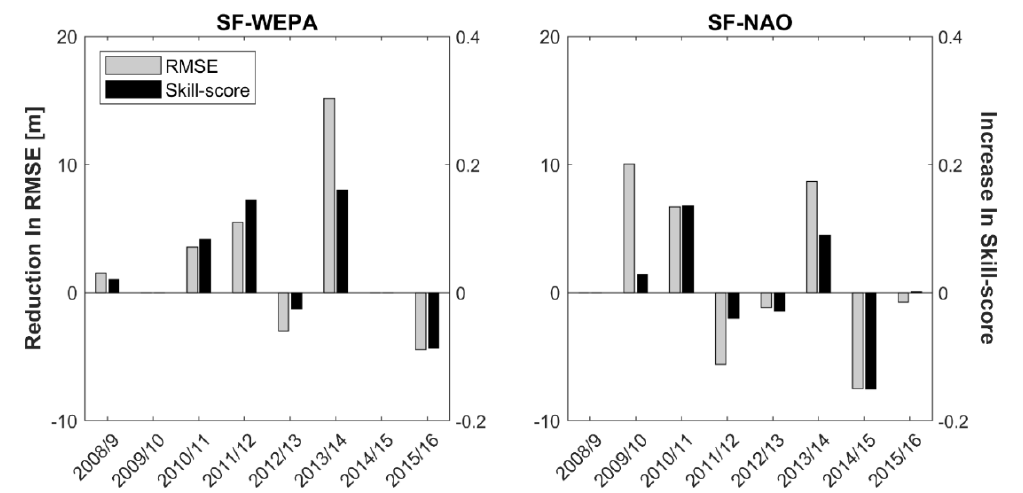
Figure 8. Compares RMSE and skill scores for the climate index-informed models against that of SF-Uninf. Bars above the line indicate improvements in forecast skill, either reductions in RMSE or increases in skill score.